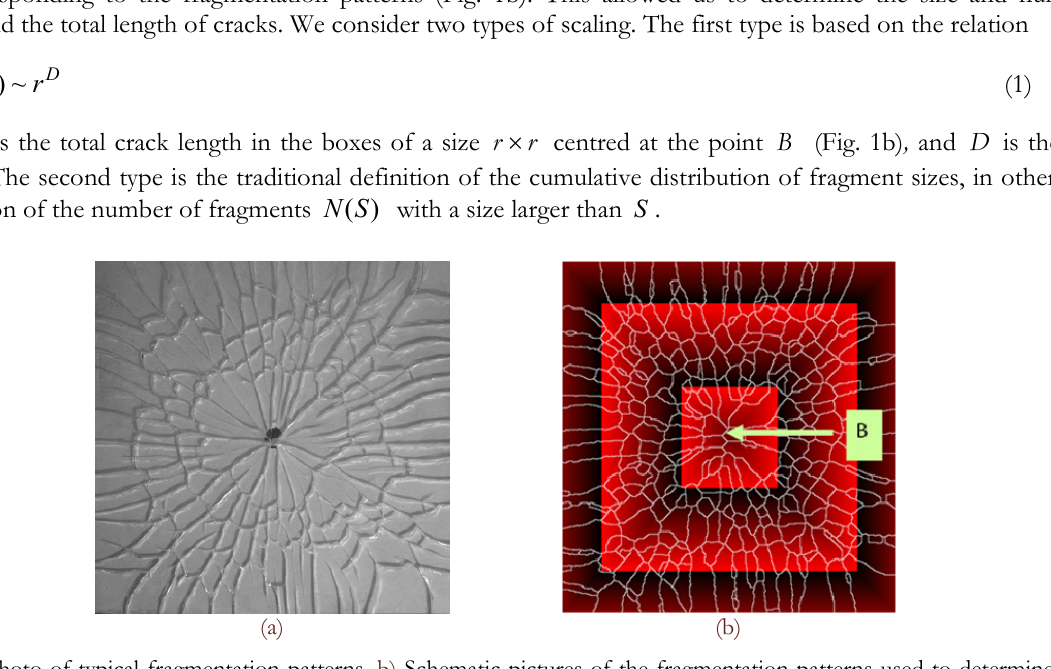
Figure 1: a) Photo of typical fragmentation patterns. b) Schematic pictures of the fragmentation patterns used to determine the size and number of fragments and the total length of